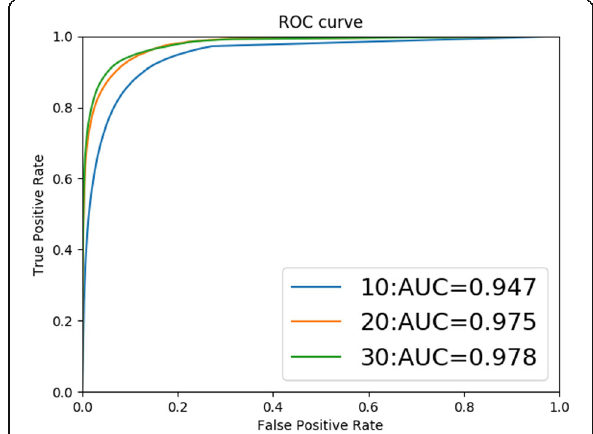
Fig. 3 ROC curves and AUCs for the dust storm class. The blue, red, and green lines correspond to the patch sizes of 10 × 10, 20 × 20, and 30 × 30 pixels, respectively